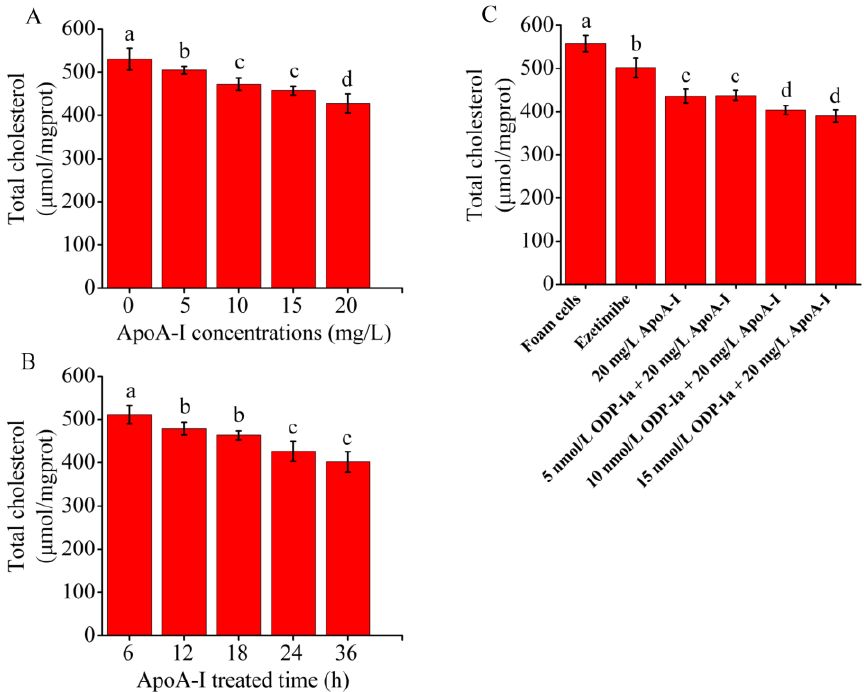
Figure 3. Effects of apoA-I on cholesterol accumulation in THP-1 macrophage-derived foam cells. Values are mean ± SD, n = 5. ( A , B ) Total cholesterol content of THP-1 macrophages decreased in a time- and concentration-dependent manner in the apoA-I-treated foam cells. ( C ) apoA-I-induced cholesterol efflux mediated by ODP-Ia. Different superscript letters indicate multiple comparisons with significant differences (SNK-q test, p < 0.05).